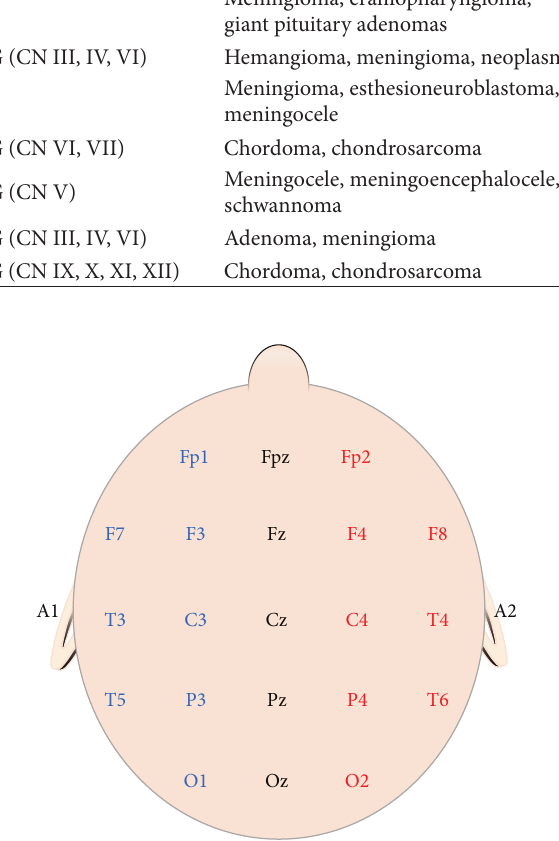
Figure 1: Common EEG recording locations using the International 10–20 System for Electrode Placement [28]. F: frontal; C: central; T: temporal; P: parietal; O: occipital; A: auricular; z: